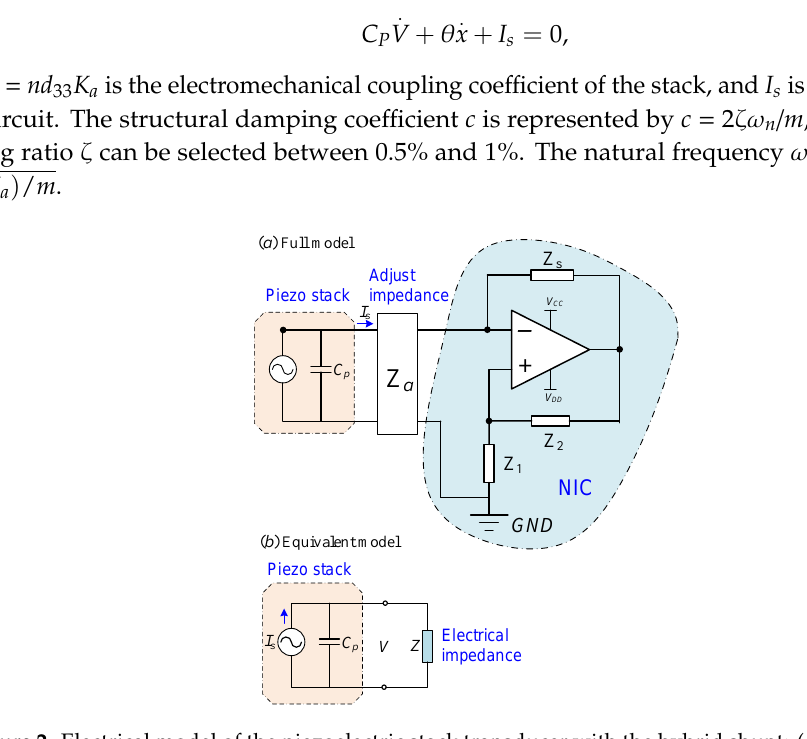
Figure 2. Electrical model of the piezoelectric stack transducer with the hybrid shunt: ( a ) full schematic, and ( b ) equivalent impedance model.